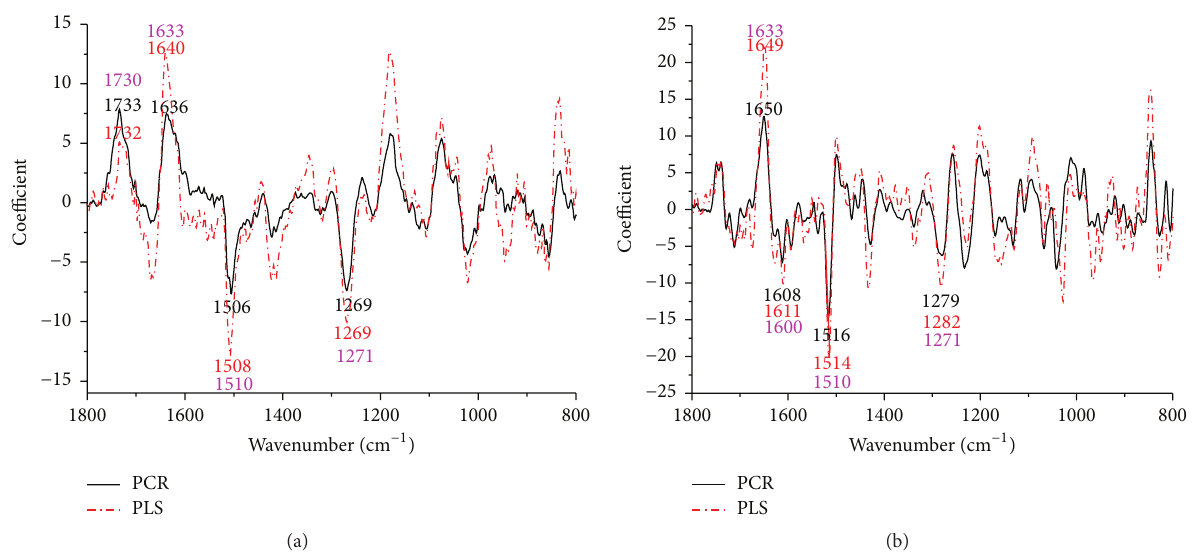
Figure 2: Coefficients by wavenumber for PCR and PLS for extractives prediction (a) when raw spectra were processed and (b) when a first- derivative pretreatment was processed. PC numbers 9, 2, 3, and 1 were chosen for PCR-raw, PLS-raw, PCR-derivative, and PLS derivative, respectively ( 𝛼 = 0.05 ).